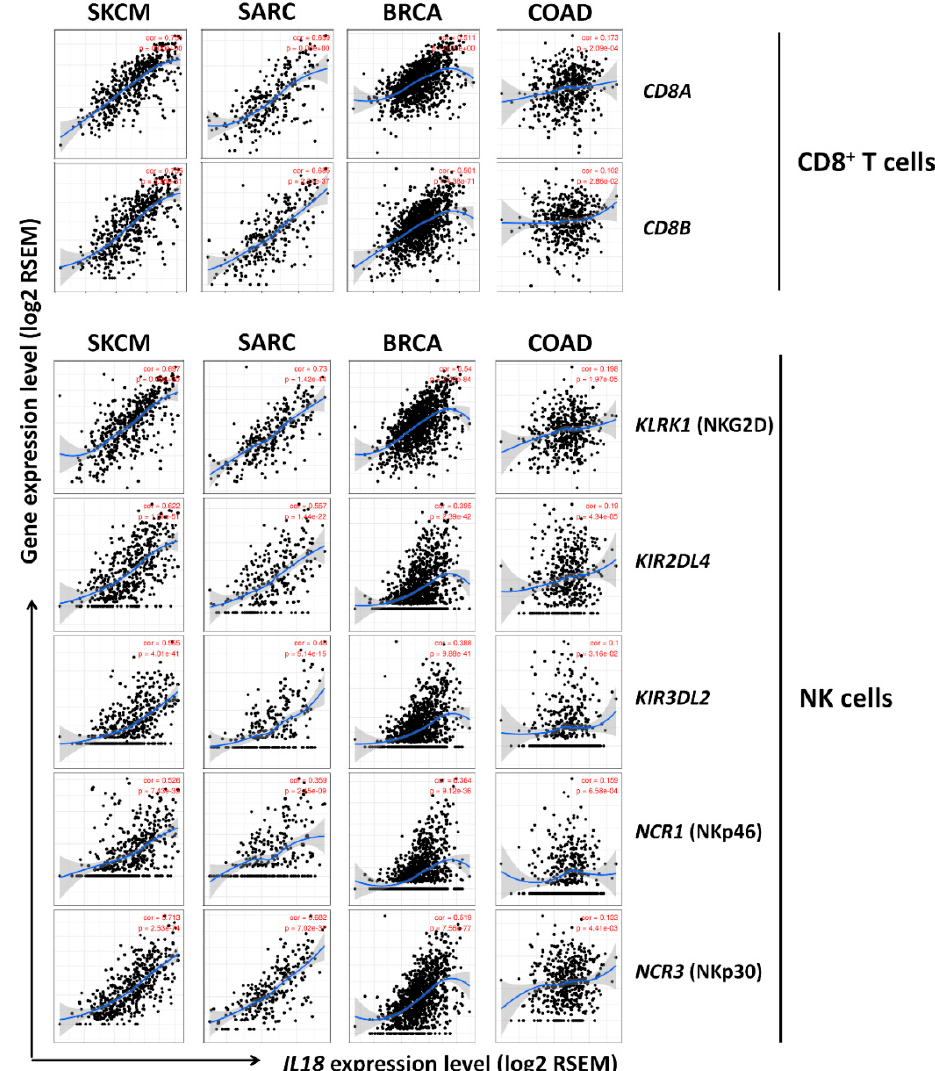
Figure 5. Correlation of IL18 expression to markers of CD8 + T and NK cells in SKCM. Correlation of IL18 expression with various gene markers of CD8 + T and NK cells was examined with the TIMER website. CD8A and CD8B genes were used as markers for CD8 + T cells, and KLRK1, KIR2DL4, KIR3DL2, NCR1, and NCR3 were used as markers for NK cells. IL18 expression was positively correlated with the expression of various gene markers for CD8 + T and NK cells in SKCM ( n = 103), SARC ( n = 259) and BRCA ( n = 1093). There are no significant correlations between IL18 expression and the expression of most gene markers in COAD ( n = 457). Only the expressions of one gene marker, KLRK1 was weakly correlated with IL18 expression in COAD. Correlation constants and P -values are listed in Table 1.